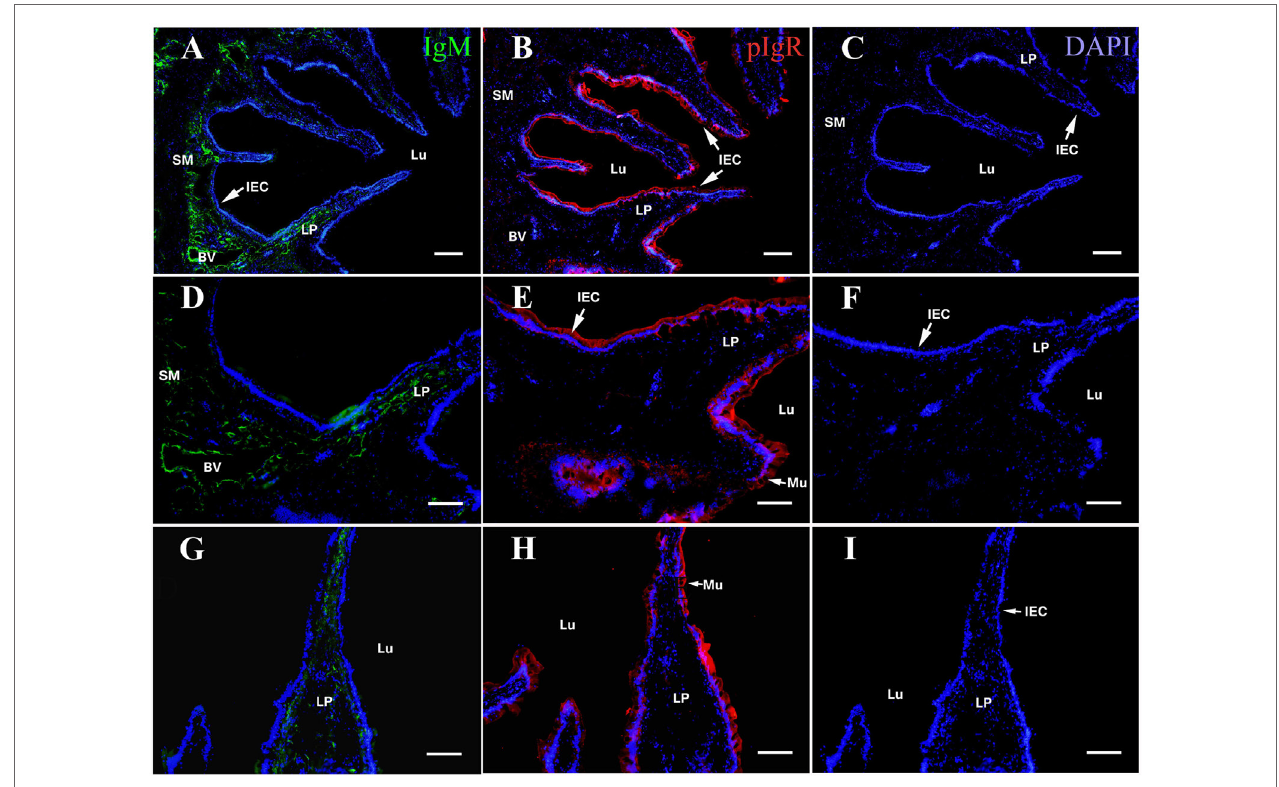
FigUre 1 | Indirect immunofluorescence of ovalbumin (OVA), pIgR, and IgM on the fourth week after initiating immunization of healthy flounder. (a) IgM was detected in lamina propria (LP) sunbmucosa of the fish hindgut of group 1 using anti-IgM monoclonal antibody 2D8. (B) The pIgR was distributed in mucosal epithelial cells of the fish hindgut of group 1. (c) No OVA was seen in the hindgut in group 1. (D) Higher magnification of (a) ; (e) higher magnifications of (B) ; (F) higher magnifications of (c) . (g) IgM staining in LP submucosa of the fish hindgut of group 2. (h) pIgR was distributed in mucosal epithelial cells of the fish hindgut of group 2. (i) No OVA was seen in the fish hindgut of group 2. Bar was 100 µm for (a–c) and 60 µm for (D–i)